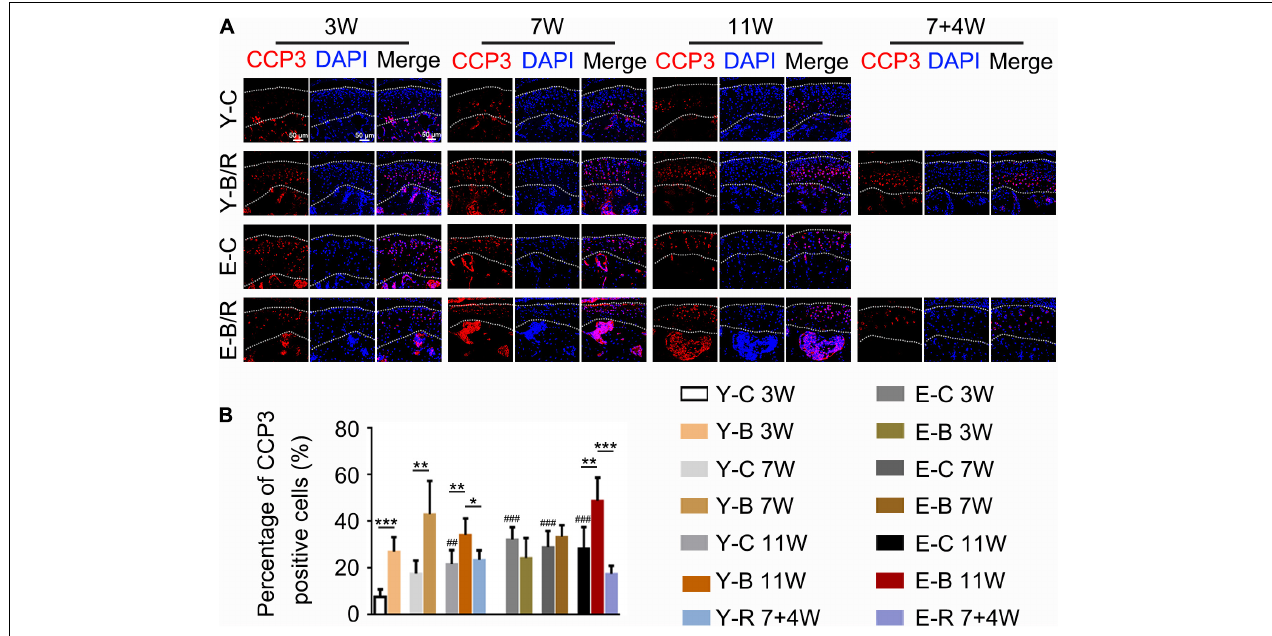
FIGURE 10 | (A) Representative cleaved Caspase-3 (CCP3) immunofluorescence staining. Bars = 50 µ m. (B) Comparisons of the percentages of CCP3-positive cells in the cartilage between the groups. Data are presented as mean ± SD. Unpaired t -test was used for comparisons between the age-matched control and BAC groups. One-way ANOVA was used for comparisons among the age-matched control, BAC, and BAC removal groups, and the comparisons among the six time points in control groups. n = 6. * P < 0.05, ** P < 0.01 and *** P < 0.001 for the differences between all BAC and removal groups and the age-matched control groups. ## P < 0.01, ### P < 0.001 for the differences between each time points control groups and the younger 3-week control group. For grouping and time points, please refer to Figure 1A